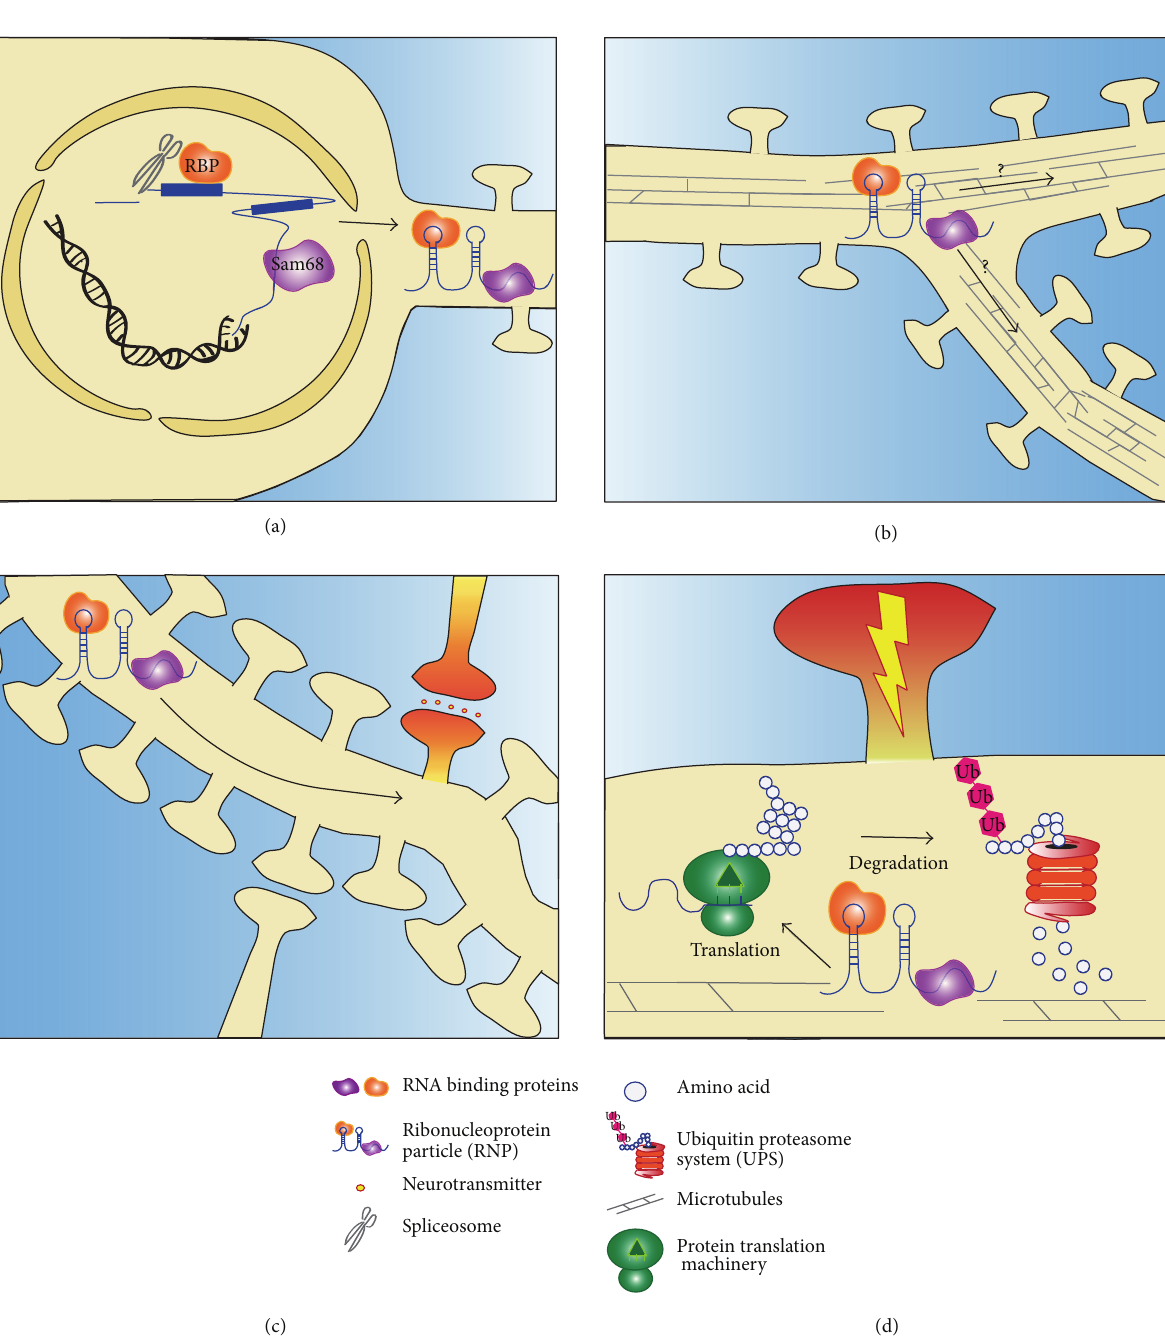
Figure 1: The trials and tribulations of RBPs and RNPs. (a) RBPs assemble cotranscriptionally and regulate mRNA splicing and modification preventing the coassembly of multiple mRNAs per RNP. Motifs in the 5 󸀠 UTR and 3 󸀠 UTR as well as retained intronic sequences facilitate dendritic targeting of RNPs. (b) RBPs transport mRNAs along microtubules to destinations dictated by the cargo mRNA sequence. Through input-specific events, synapses or dendritic branches may autonomously regulate their mRNA content. (c) Excitatory synapses at dendritic spines greatly outnumber mRNAs in dendrites and even more so counting inhibitory synapses. Despite being sparsely distributed, local mRNAs contribute significantly to synaptic function. (d) Upon synaptic stimulation, RBP function determines mRNA fate. Derepression by translational repressors can be followed by promotion of translation by RBPs like Sam68 (purple). Translation is counterbalanced by proteasomal or lysosomal